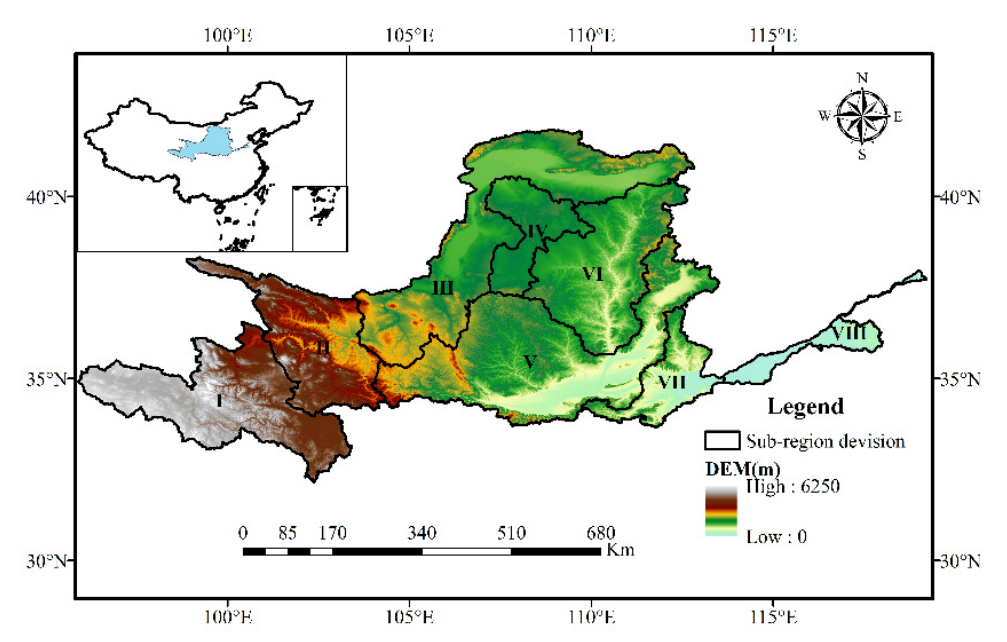
Figure 1. Division of the eight water resource zones in YRB.